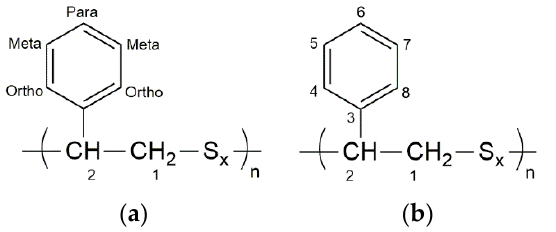
Figure 11. The assignment of numbers to individual atoms in the structure of synthesized polysulfides related to ( a ) 1 H NMR; ( b ) 13 C NMR. Table 2. The 1 H NMR chemical shifts in poly (StS) and StS / S 8 copolymers.